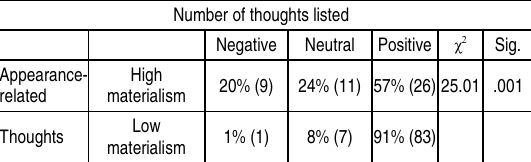
Table 8B. Chi-square analysis for